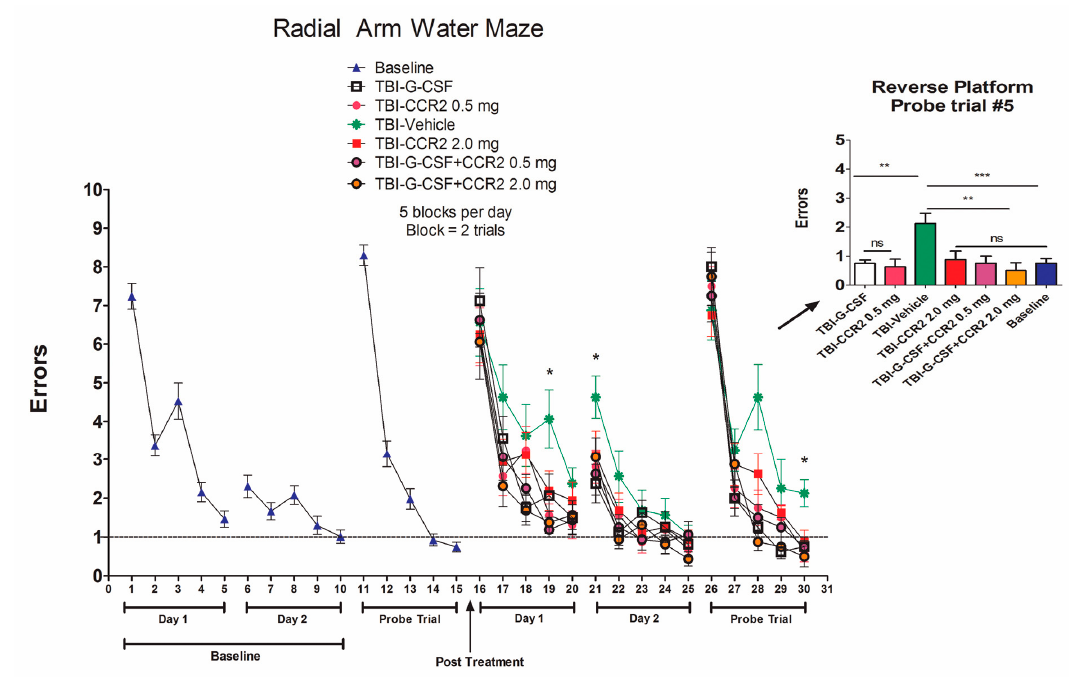
Figure 4. Effects of G-CSF and CCR2 antagonist treatment on performance in the Radial Arm Water Maze (RAWM). Summary data is plotted as the mean number of errors on the y -axis and trials on the x -axis. Baseline training on the RAWM was performed for three days before CCI. Drugs were then administered daily for three days after CCI. The RAWM was repeated on day 12 with reversal testing on day 14 post CCI (bar graphs). Asterisks indicate significant differences between treatments compared to each other and compared to baseline performance (* p <0.05), based on one-way ANOVA (*** p = 0.008) followed by Bonferroni multiple comparison tests (** p < 0.05).